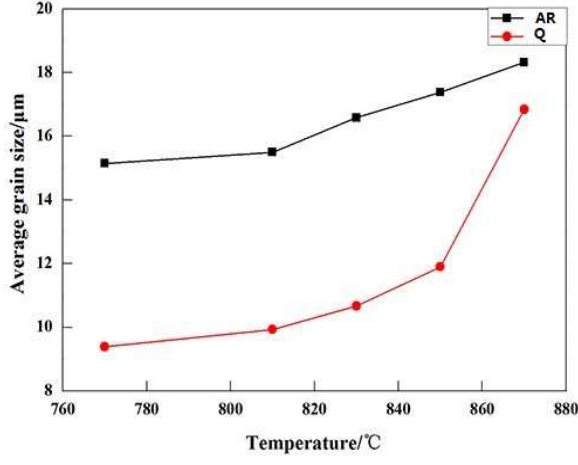
Figure 5. Grain size of rolled and quenched specimens in the sub-temperature zone. Table 2. Austenite grain sizes and grades of the steel at different heating temperatures.